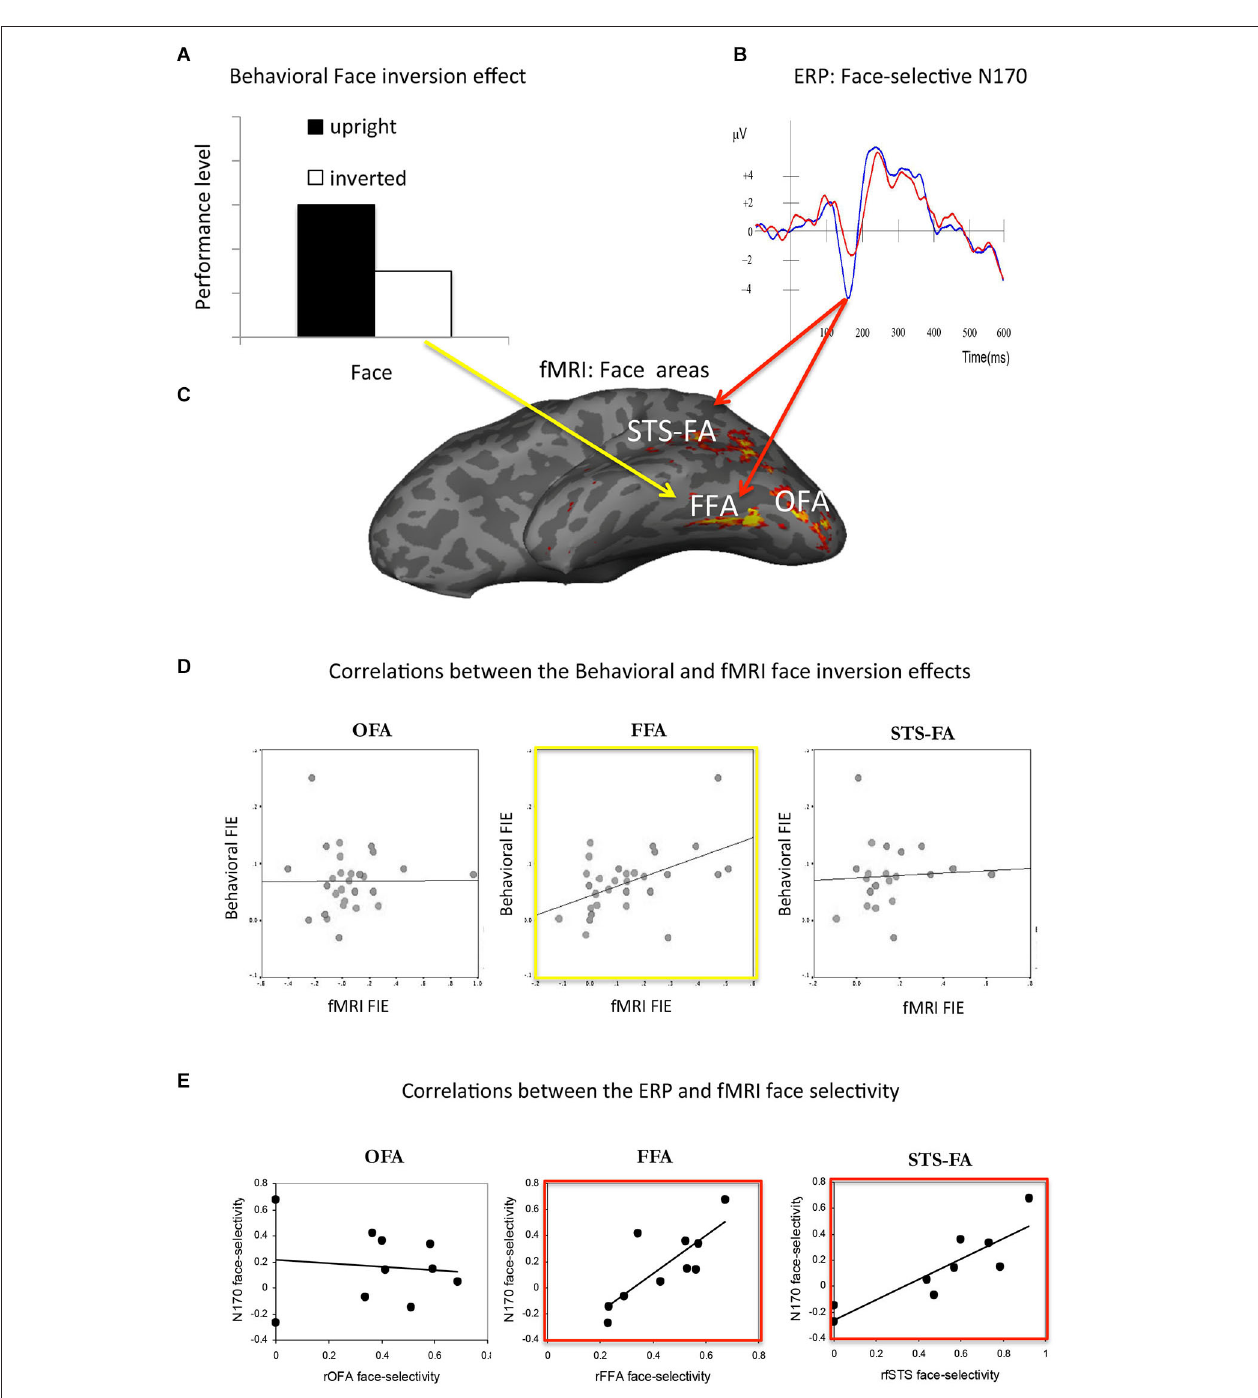
area (STS-FA) in the posterior part of the STS. (D) The association between the behavioral face inversion effect (i.e., difference in performance level for upright than inverted faces) and the fMRI face inversion effect (i.e., difference in fMRI response to upright than inverted faces) was found only with the FFA (Yovel and Kanwisher, 2005). (E) Correlations among the magnitude of face selectivity (i.e., difference in ERP or fMRI response to faces than non-faces) was found at 170 ms with the FFA and STS-FA, but not with the OFA (Sadeh et al.,